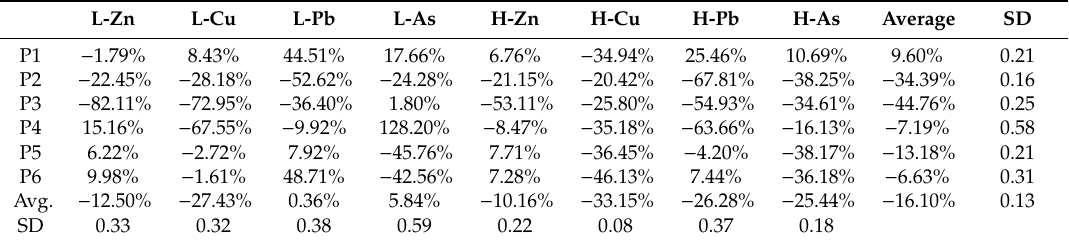
Table 1. Descriptive statistics of relative errors for the estimation of Zn, Cu, Pb and As loads in